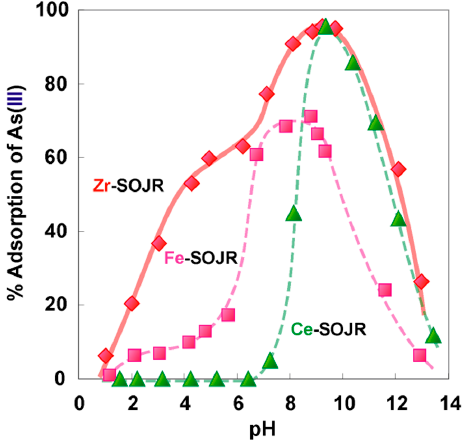
Figure 23. % adsorption of As(III) by SOJR gel loaded with Fe(III), Ce(III) and Zr(IV) at different equilibrium pH values [16]. (With permission for reuse from Indonesian Chemical Society). pH values [16]. (With permission for reuse from Indonesian Chemical Society).